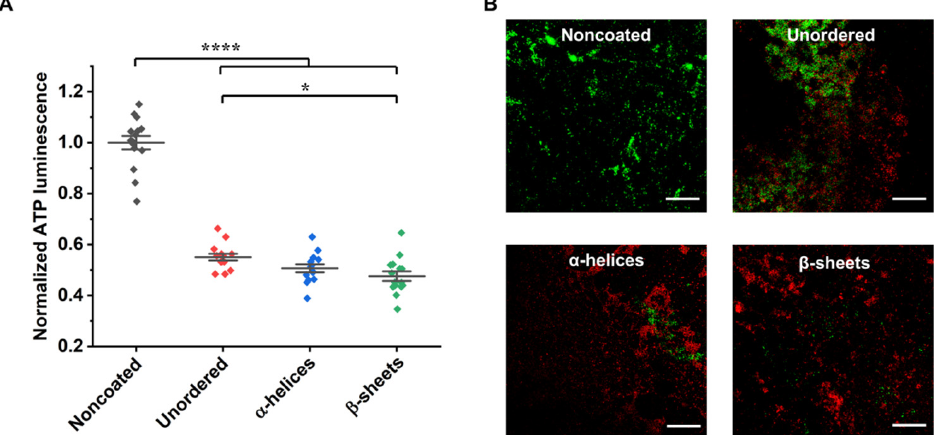
Figure 5. Antimicrobial test of the different coatings against S. aureus . ( A ) Normalized ATP lumi- nescence intensity and ( B ) representative LIVE/DEAD CLSM images of colonized S. aureus on the Ti surfaces with no coatings or GL13K coatings prepared as unordered peptides, self-assembled α -helices, and self-assembled β -sheets. Scar bars are 50 µm. N = 15 for each group. * p -value < 0.05, **** p -value < 0.0001.